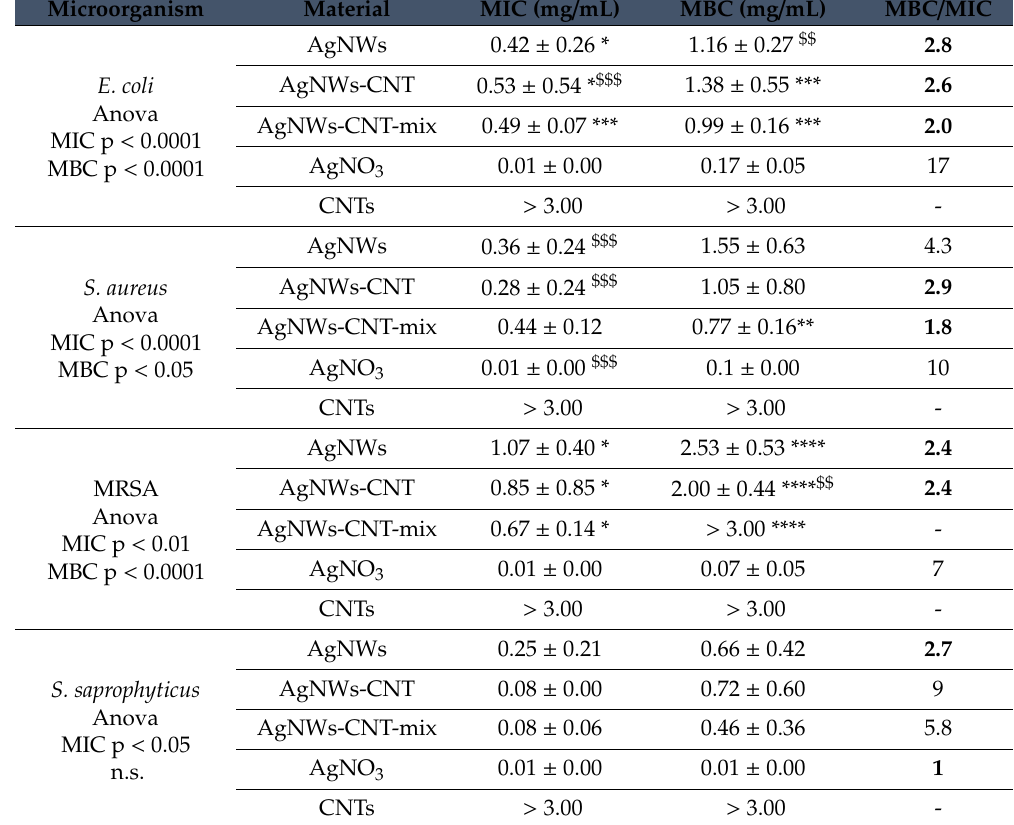
Table 1. MIC and MBC values (mg / mL) for AgNWs, AgNWs-CNT, AgNWs-CNT-mix, AgNO 3 and CNTs. Data are reported as the mean ± SD ( n ≥ 3). One-way ANOVA results are reported in the table. The post hoc Tukey multiple comparisons test results are shown with *when compared to Ag + and with $ when compared to AgNW-CNT-mix. * ,$ p < 0.05; ** ,$$ p < 0.01, *** ,$$$ p < 0.001 and **** ,$$$$ p <